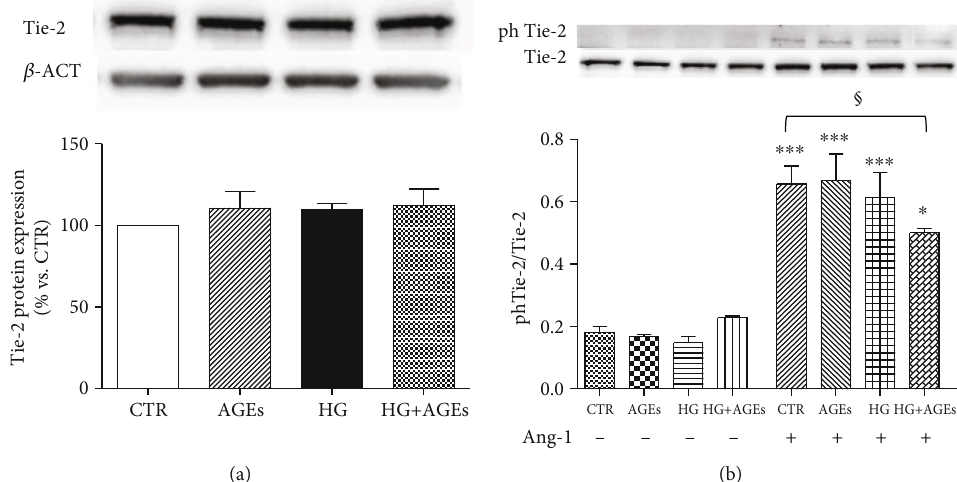
Figure 2: AGEs and HG did not alter the expression and phosphorylation of Tie-2. (a) Western immunoblotting of Tie-2 in HMEC-1 cells cultured for 5 days in CTR, AGEs, HG, and HG+AGEs. (b) After the 5-day treatment described above, HMEC-1 cells were incubated for 2 hours in serum-free medium and, then, exposed for 30 min to PBS (control) or Ang-1 (200ng/ml). Then, Tie-2 and phosphoTie-2 were analyzed. Representative western blot analysis and quanti fi cation of densitometries of western blot band. Data were expressed as mean ± SEM of fold induction relative to β -actin (a) or to relative expression of Tie-2 and phTie-2 (b) ( n = 4 ). ∗ p < 0 : 05 and ∗∗∗ p < 0 : 001 vs. same culture condition in the absence of